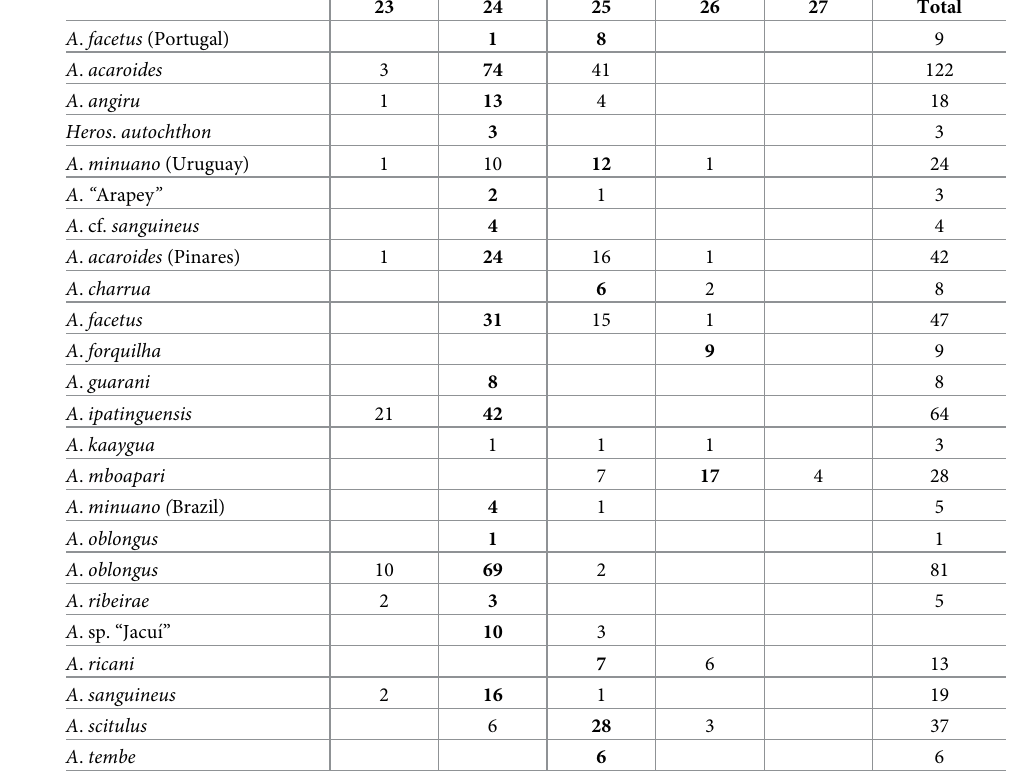
Modal frequencies marked in bold for samples with N > 5. HT = Holotype; ST =